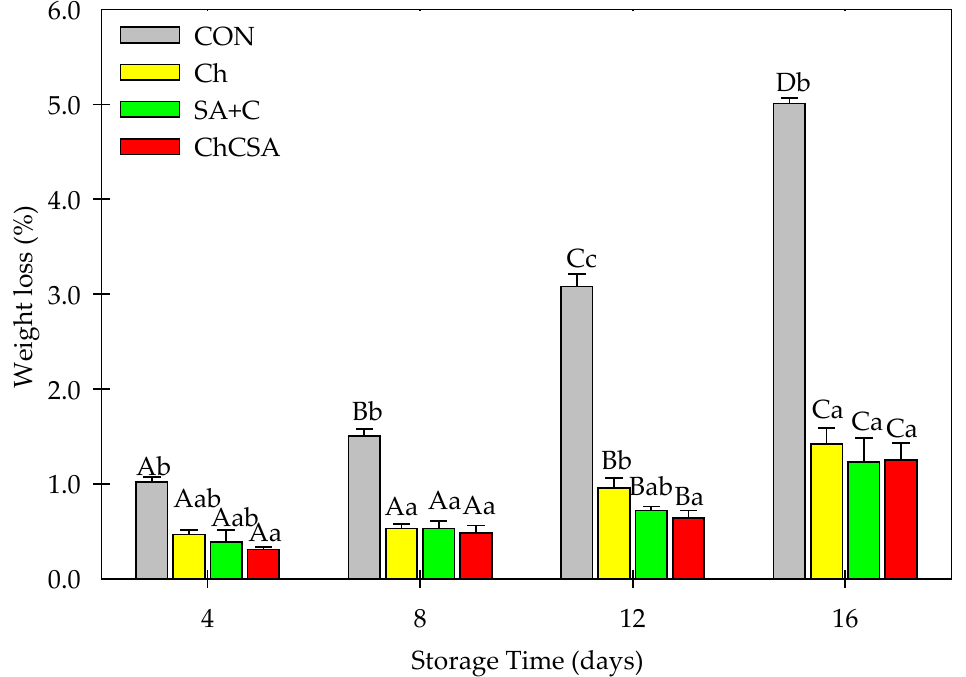
Figure 2. The effect of single-layer and gel coatings on the percentage of weight loss of fresh-cut purple sweet potatoes. Vertical bars represent means and standard deviation. Bars with different alphabets within the same storage day (lower case) or same treatment group at different storage days (upper case) are significantly different (Tukey’s HSD Test, p ≤ 0.05).